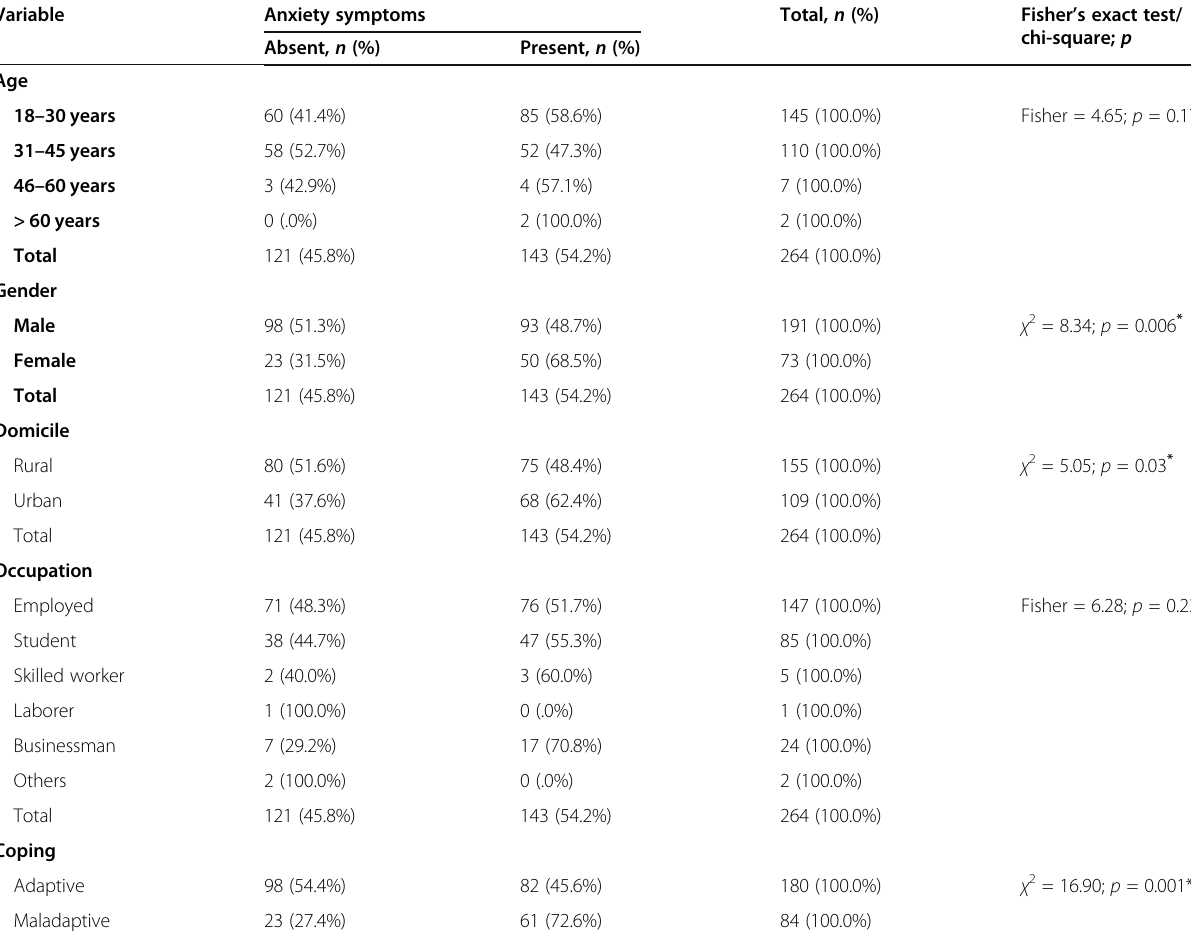
Table 2 Socio-demographic variables in relation to anxiety symptoms ( N = 264) Variable Anxiety